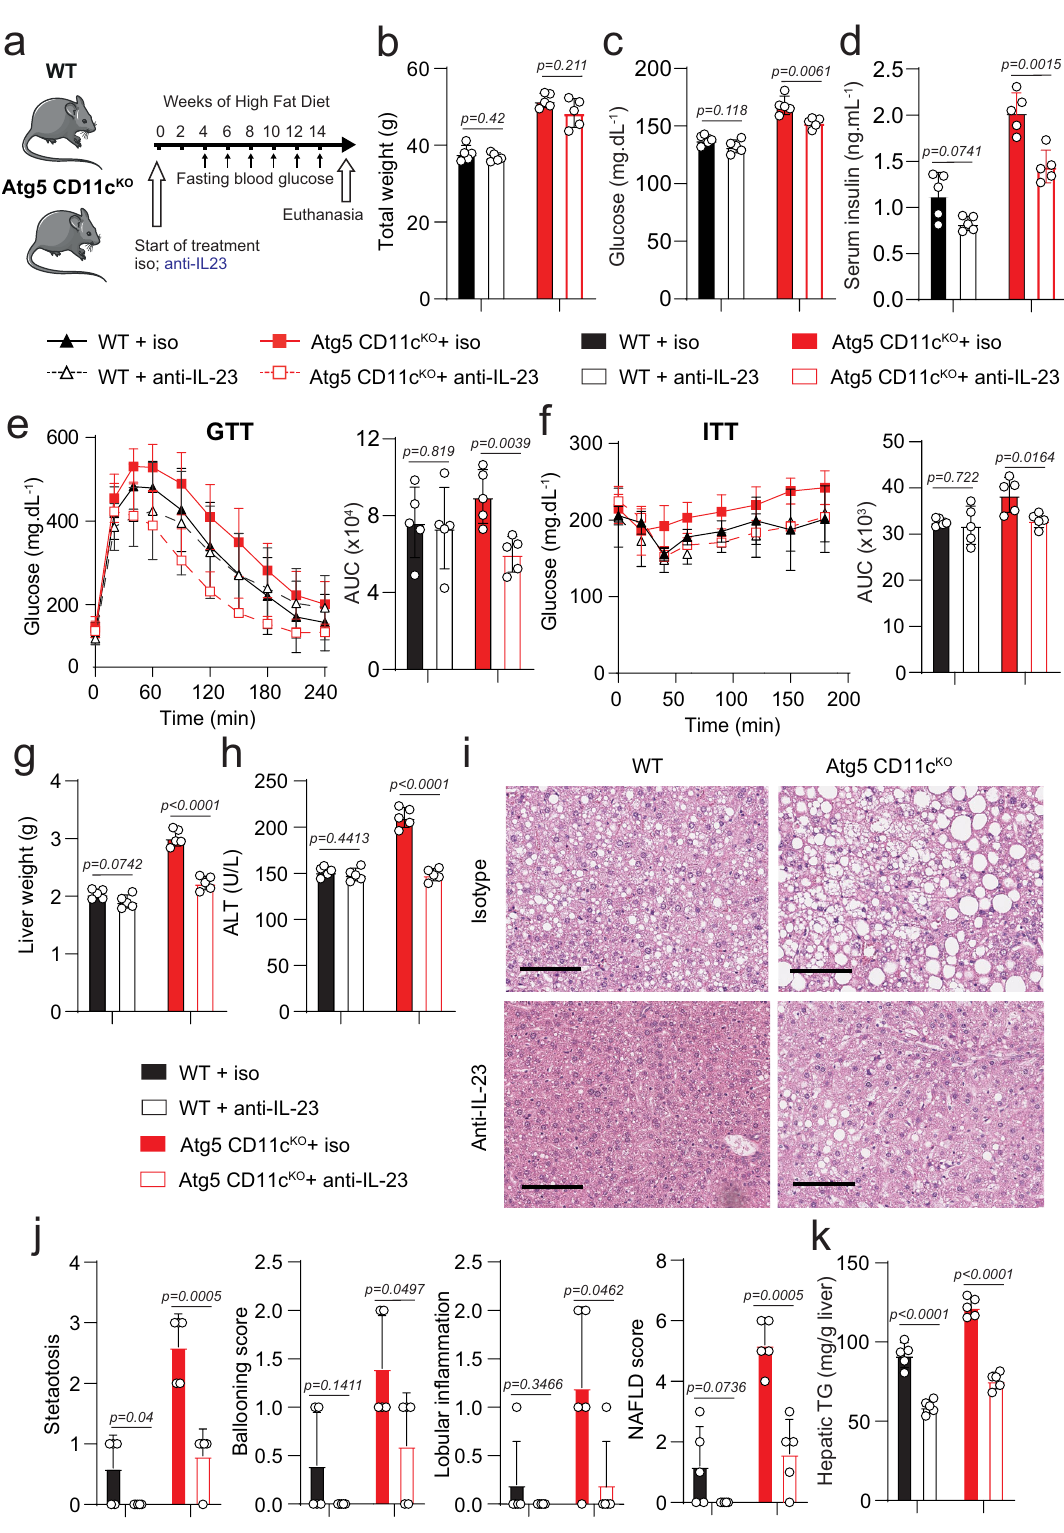
Fig. 6a – c). We con fi rmed that Atg5 CD11c KO mice were hea- anti-IL-23 treatment had an effect on glucose and insulin levels in vier and had signi fi cantly higher glucose and ALT levels Atg5 CD11c KO mice, with no effect on WT mice. For both genotypes, total weights were not affected by anti-IL-23 treat- when compared to controls. There were no differences among ment. Then glucose tolerance and insulin sensitivity were mice of the same genotype before the beginning of the anti-IL-23 tested and quanti fi ed (Fig. 7e, f). Anti-IL-23 treatment improved treatment. After 6 weeks of anti-IL-23 or isotype treatment, glucose tolerance and insulin sensitivity in both WT and Atg5 we weighed the mice and assessed fasting blood glucose and CD11c KO mice. insulin levels (Fig. 7b – d). Similar to our previous observations, NATURE COMMUNICATIONS| (2022) 13:1440